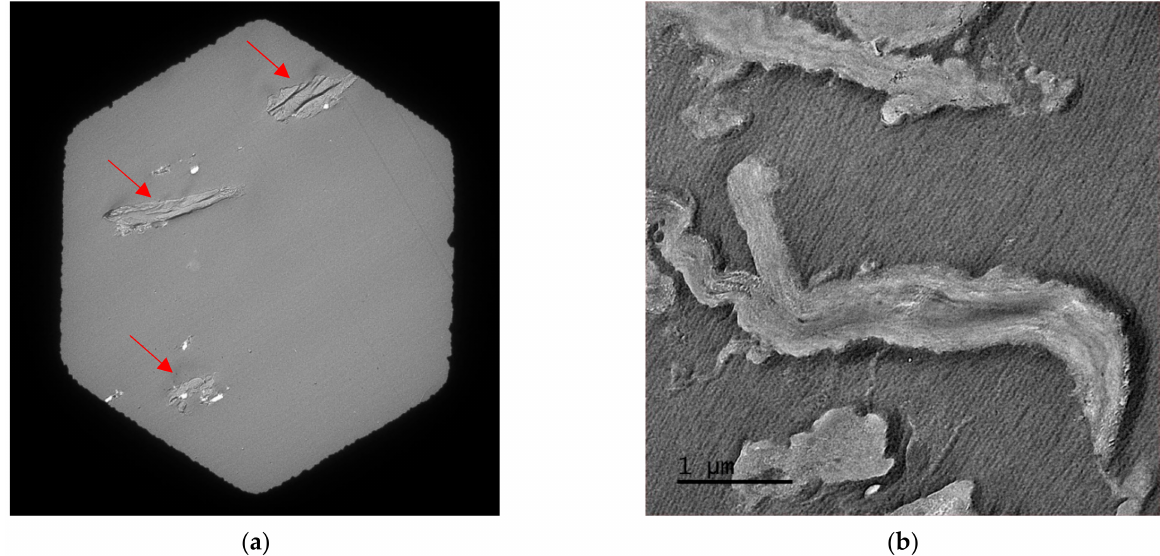
Figure 11. Transmission electron micrographs of Sigmacell-based semi-IPN, stained with 2% uranyl acetate: ( a ) Magnification 800 × ; ( b ) Magnification 6000 × . Red arrows mark visible cellulose